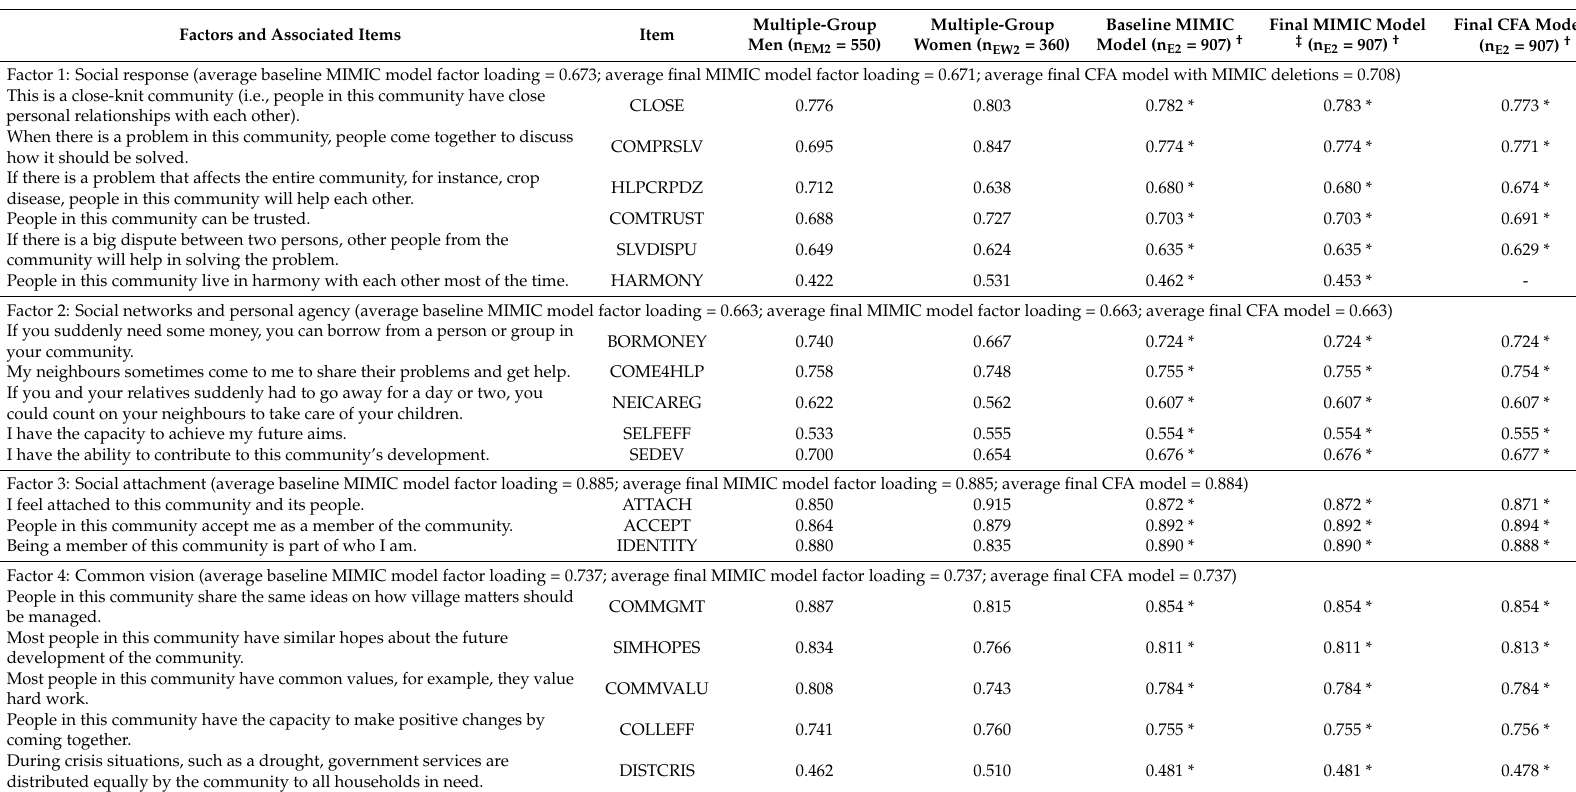
Table 6. Factor loadings and fit indices for multiple-group CFA, baseline and final MIMIC, and final CFA (with MIMIC refinement) models. Factors and Associated